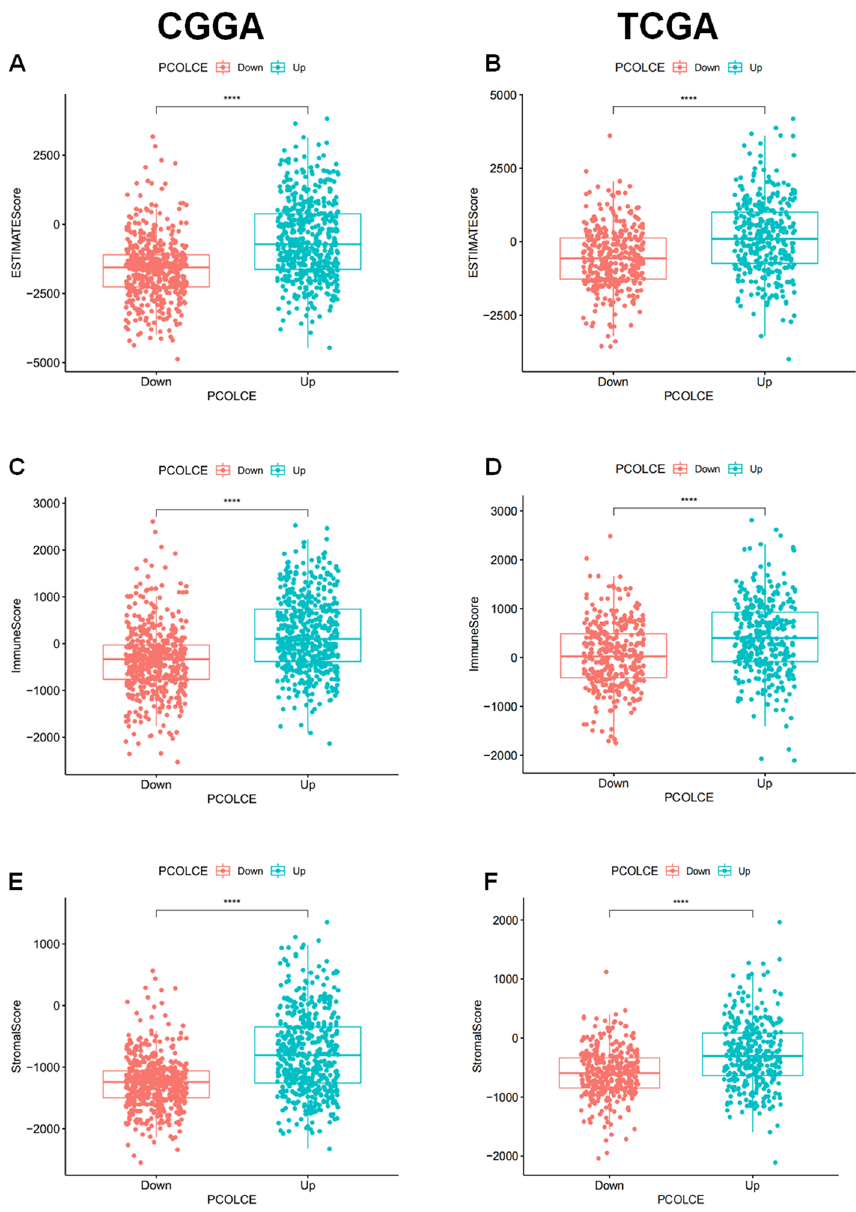
Figure 5. Relationship between scores and PCOLCE expression level in CGGA and TCGA datasets. ( A , B ) ESTIMATEScore, ( C , D ) ImmuneScore, and ( E , F ) StromalScore were higher in the group with higher PCOLCE expression. ****P <